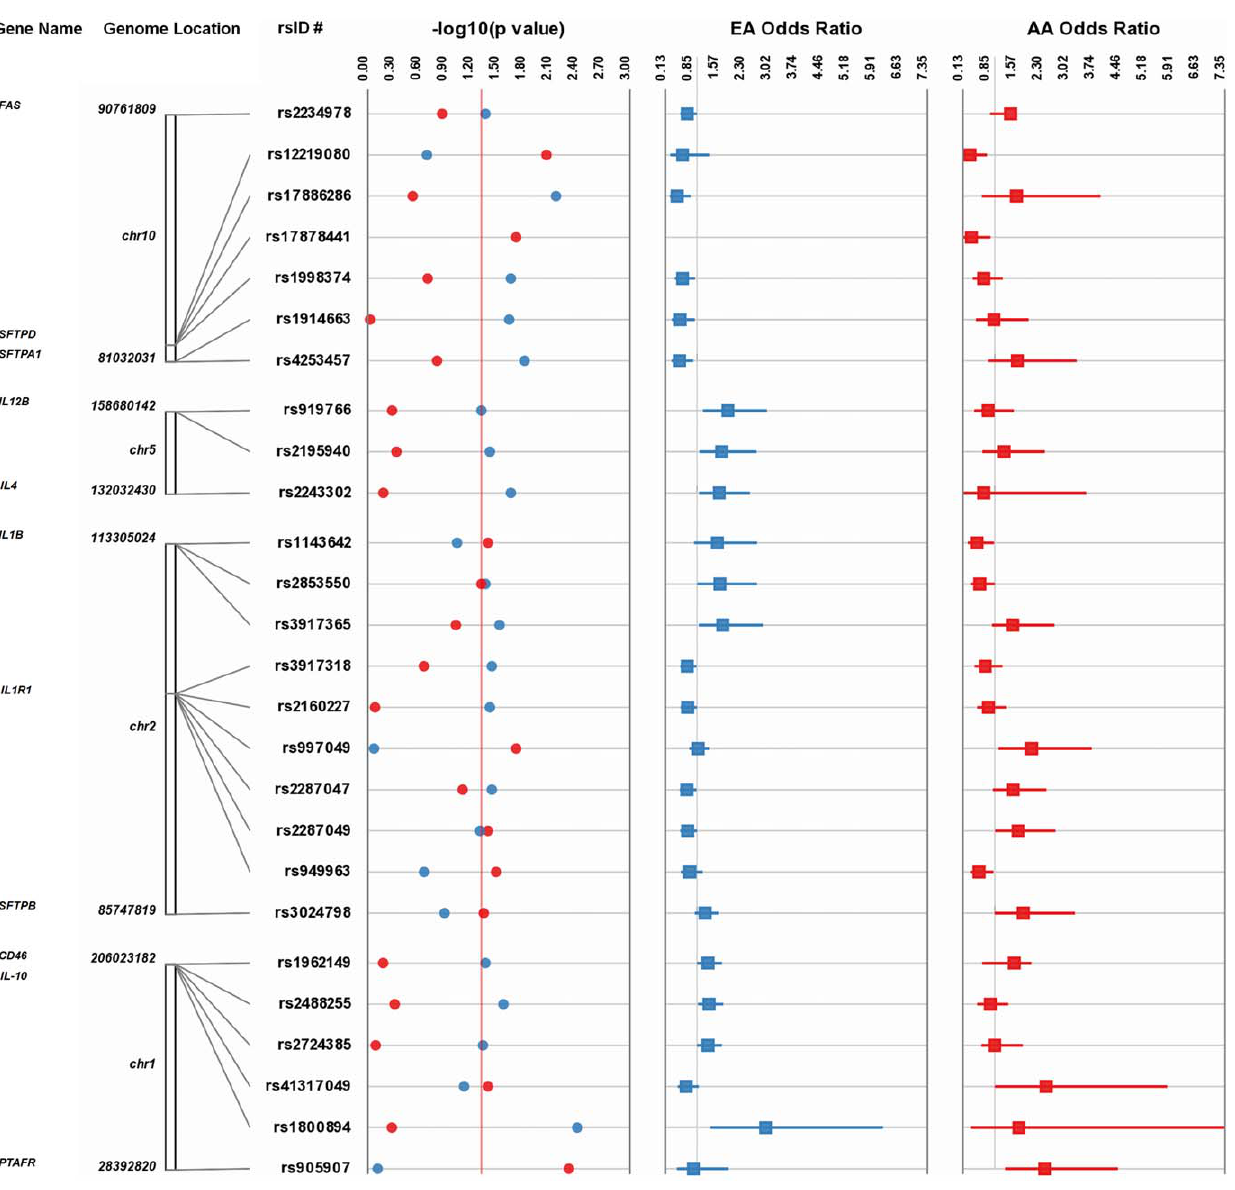
Figure 1. Summary of tagSNP associations for European-Americans and African Americans. Genomic and association characteristics for tagSNPs with p # 0.05 for IPD among either EA or AA are shown. Threshold lines for p=0.05 (-log10 (0.05) =1.3) and OR=1 are indicated in the relevant forest plots.